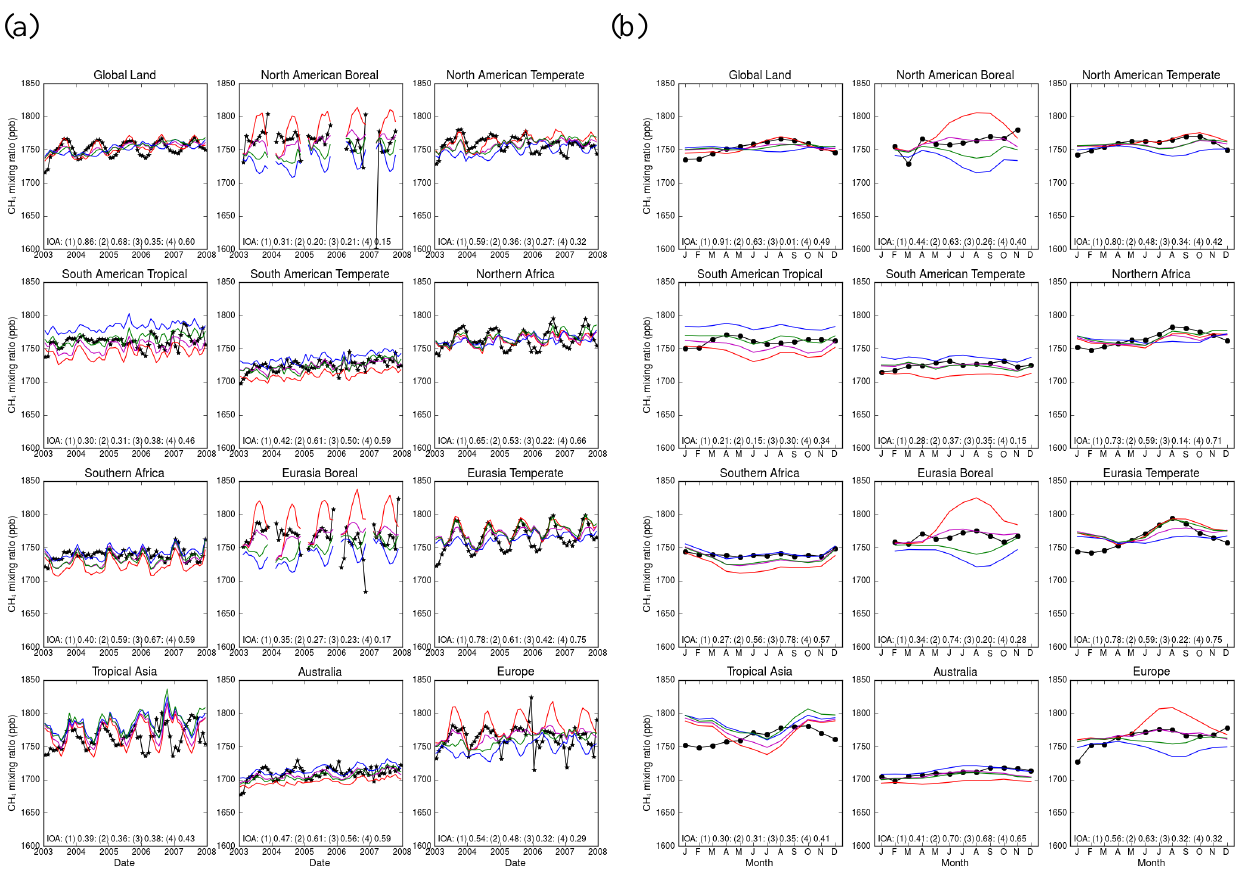
Figure 10. Time series of the area-weighted average atmospheric column methane mixing ratio from January 2003 to December 2007, as derived from monthly regridded SCIAMACHY data (v2.3) and from the HadGEM2 runs using (1) the FUNG (red), (2) the TRANSCOM FUNG (magenta), (3) the JULES (blue), and (4) the JULES-GIEMS (green) wetland emission inventories and the EDGAR v3.2 (E3.2) anthropogenic methane emission time series, sampled at co-located space and time points for all land surface points and for the 11 terrestrial TRANSCOM regions (a) . (b) shows the corresponding annual cycles. The IOA is shown for each run (see Sect.3 of the Supplement for the definition of the